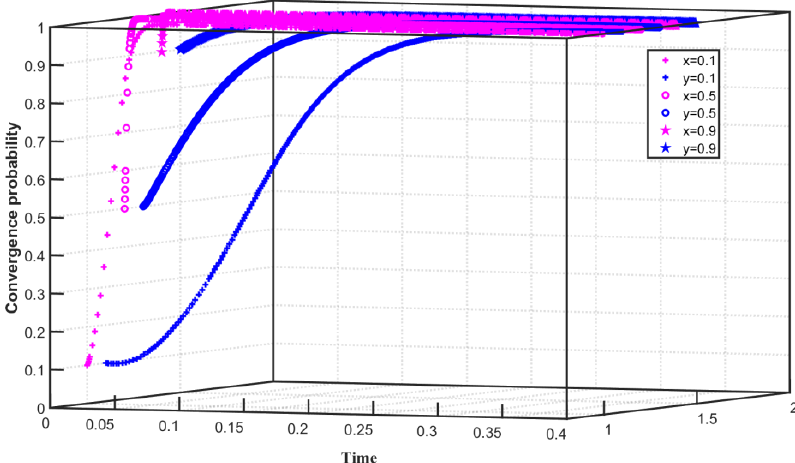
Figure 7. Evolution path of two-party game system under high free quota and low carbon emission reduction.